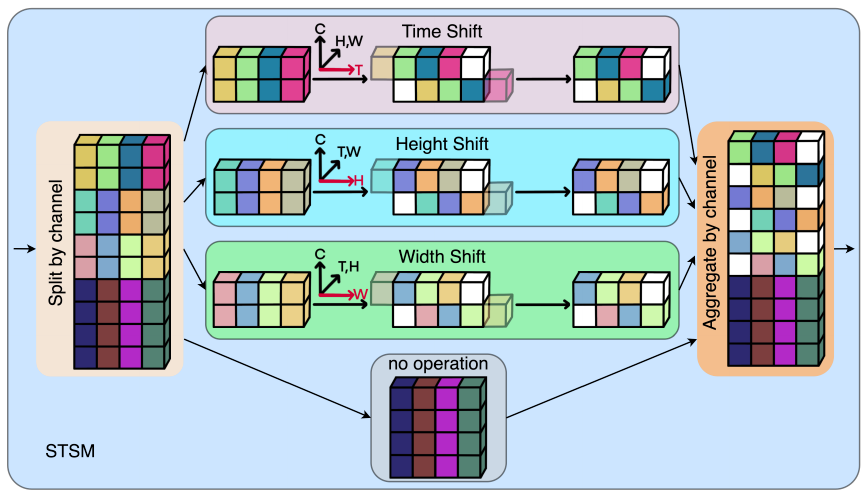
Figure 3. Time (T) + height (H) + width (W) 1D Spatio-temporal shift